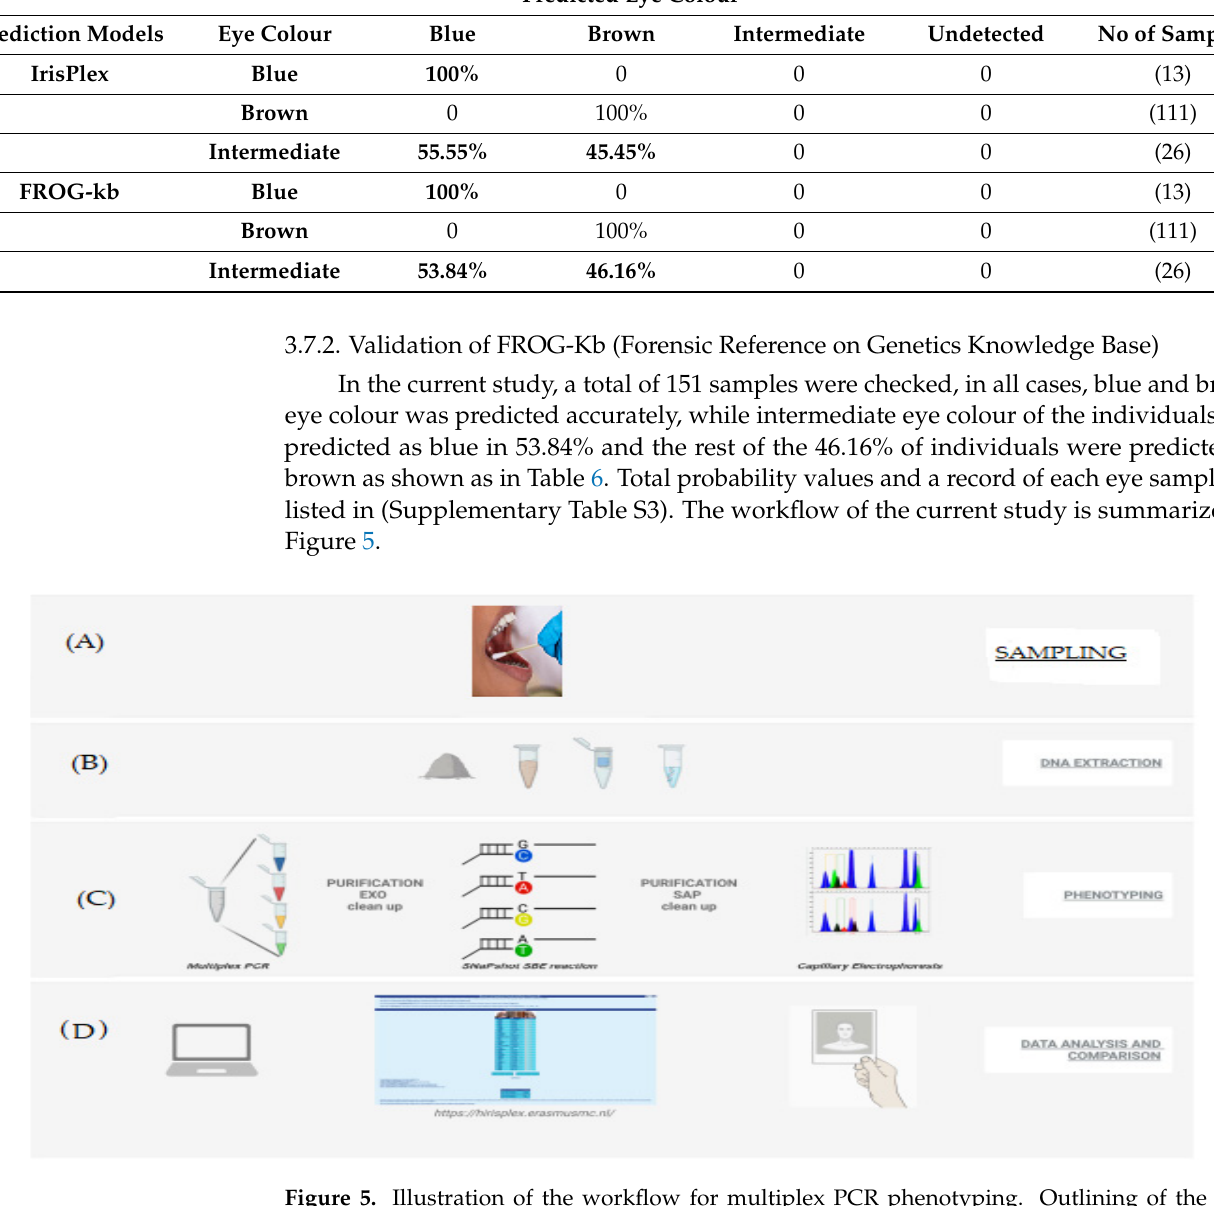
Table 6. Eye colour prediction model validation: Bold values show successful prediction estimates from the local resident Pakhtoon population.